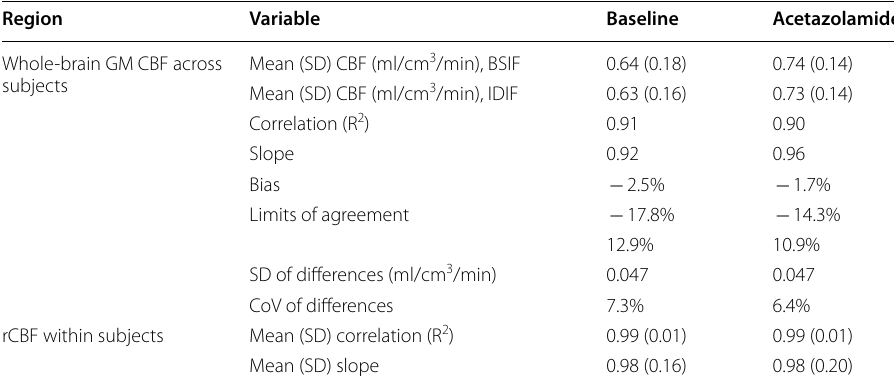
Table 1 Correlation and agreement between BSIF- and IDIF-based CBF